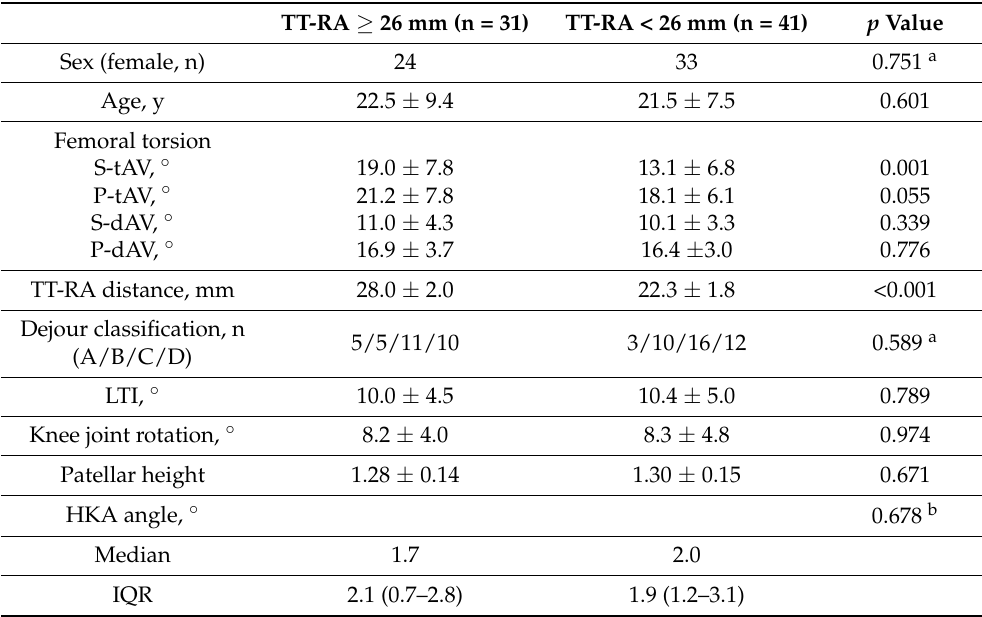
Table 4. Difference in the variables between the two examined subgroups, showing the mean and standard